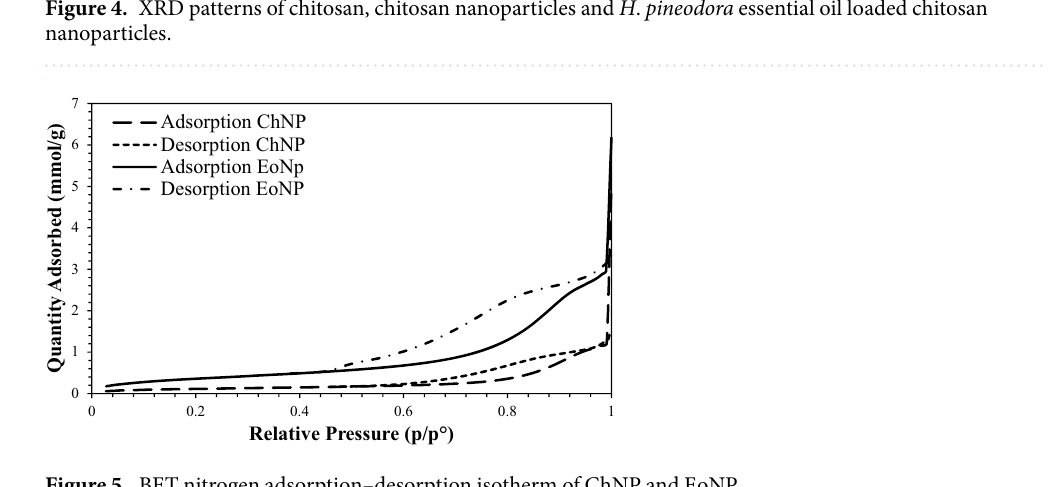
Figure 5. BET nitrogen adsorption–desorption isotherm of ChNP and EoNP.